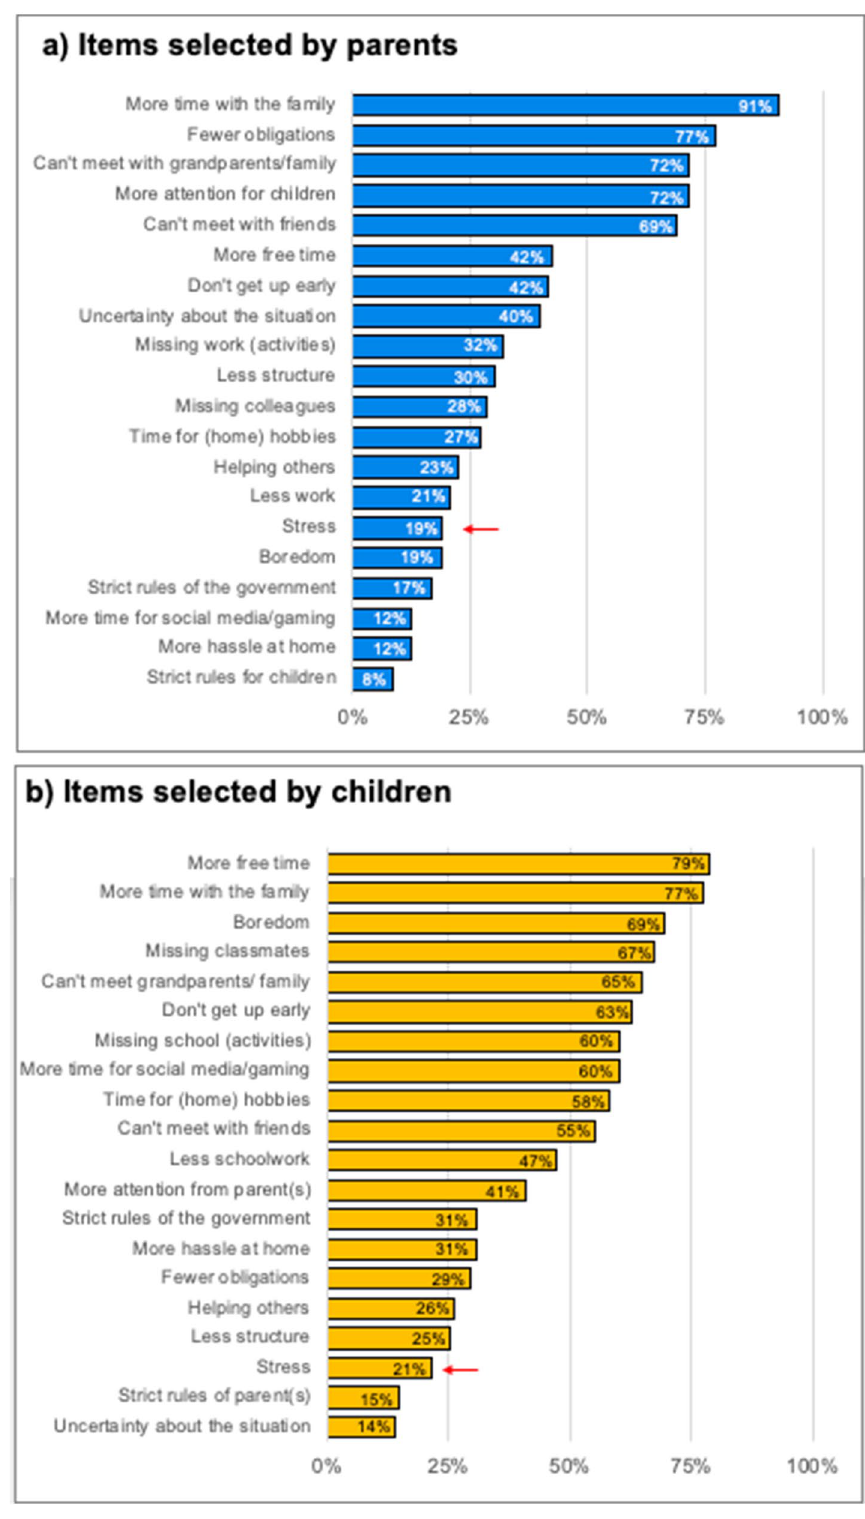
Figure 3. Percentage of selected items that parents ( a ) and children ( b ) selected to apply to them during the past two weeks of the COVID-19